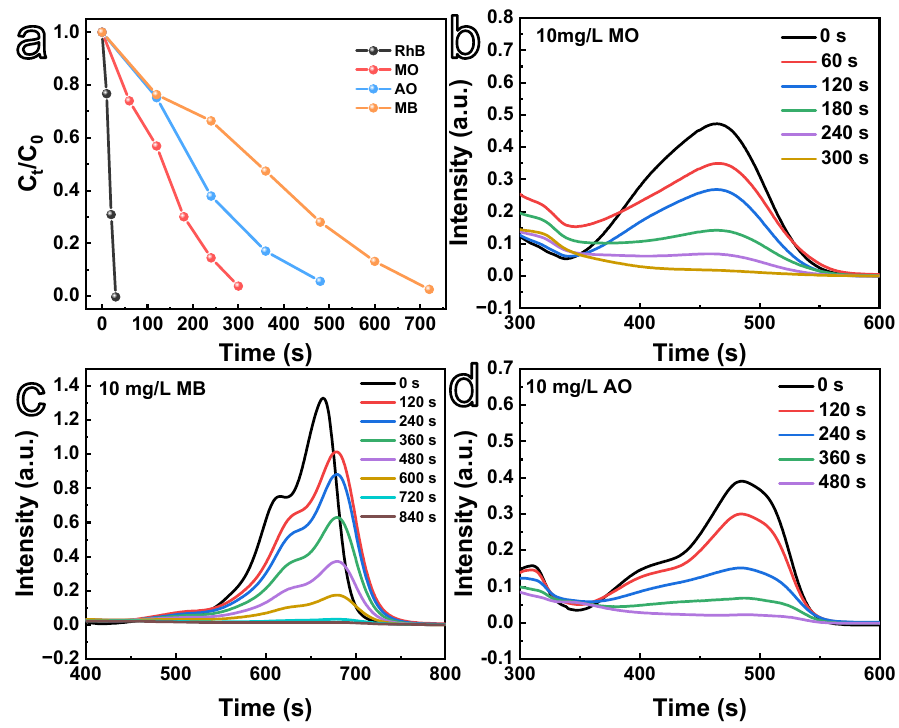
Figure 5. The typical UV absorption spectra of the ( a ) MO; ( b ) AO; ( c ) MB by the np-Ni@NiO-4 electrode for different times. ( d ) Degradation rates of different dyes versus time.